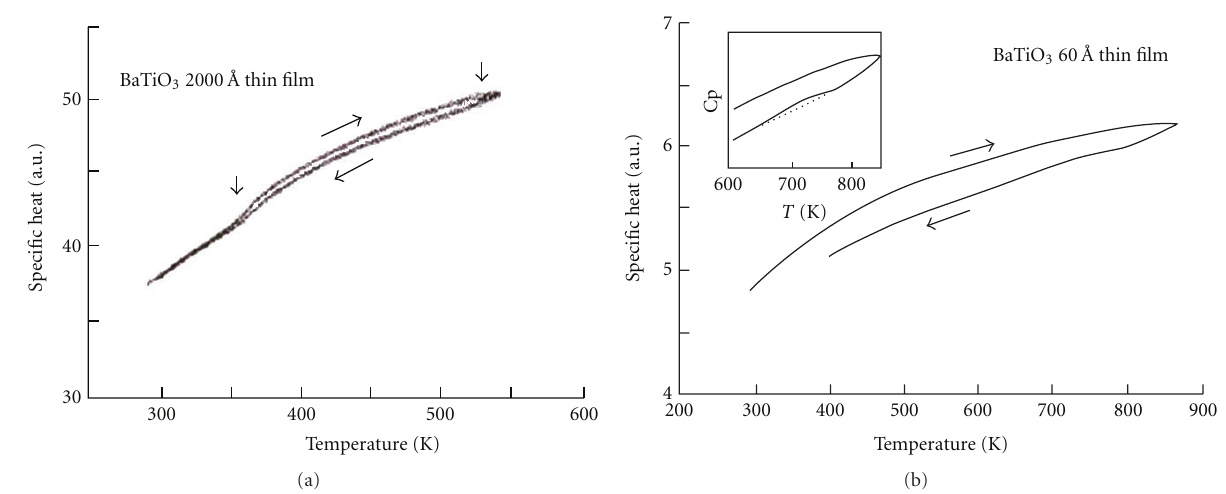
Figure 5: Temperature dependence of specific heat of BaTiO 3 epitaxial thin films on SrTiO 3 substrate; (a) 2000 ˚ A thick and (b) 60 ˚ A thick. The arrows show the direction of heating and cooling. The sharp anomalous specific heat in the single crystal changes to di ff use one in thin films [21].